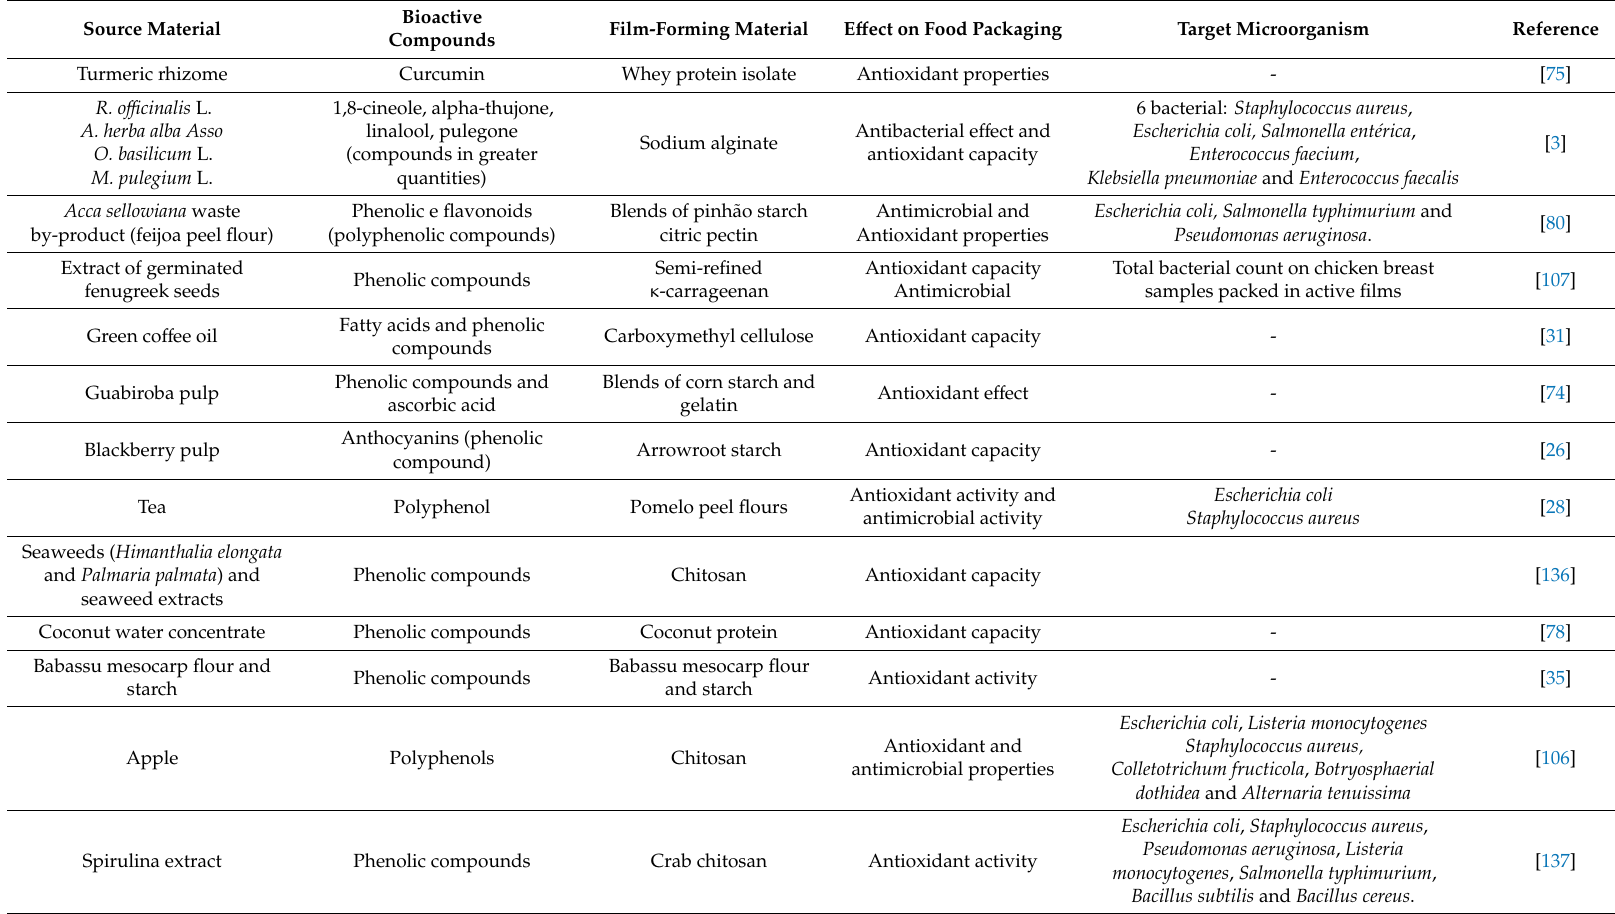
Table 2. Selected examples of bioactive compounds from plant-derived incorporated into biodegradable films and their respective properties in active